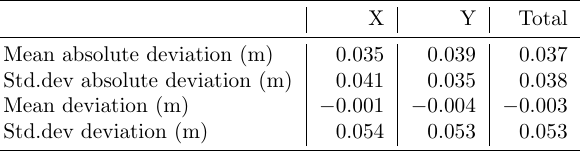
Table 3: Results from accuracy test using 94 detections compared to ground truth